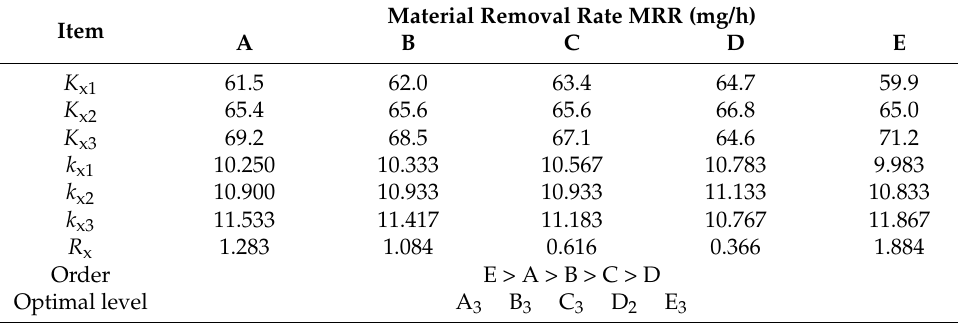
Figure 9. Influence percentage of each factor to surface roughness ( a ) and material removal rate MRR ( b ). Table 4. Intuitive analysis table for material removal rate Table 3. Intuitive analysis table for surface roughness R a.